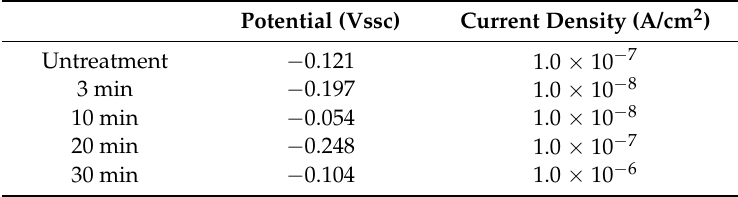
Table 3. Corrosion potential (Vssc) and current density (A/cm 2 ) of PD-HMDSZ (20 W, 60 mtorr) onto a stainless steel surface with different treatment times.